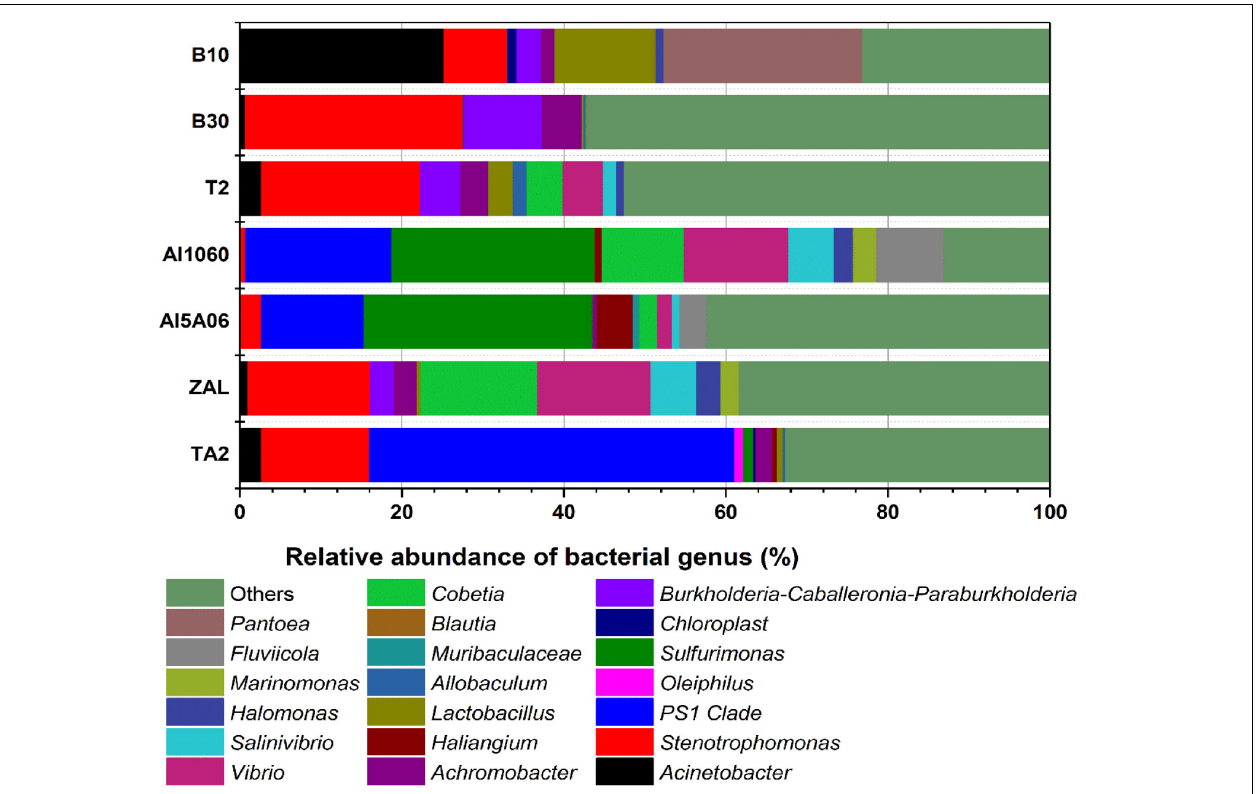
FIGURE 6 | Relative abundance of 16S rRNA gene sequences of the samples exposed in Yap Trench for 1 year at the bacterial genus level (TA2, ZAL, Al5A06, Al1060, T2, B10, and B30 represented the biofilms collected from the corresponding alloy surfaces. The top 10 abundant genera of each sample are shown in this